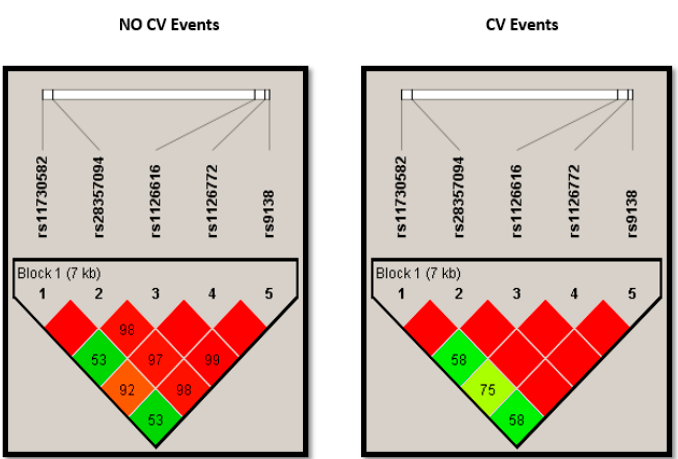
Figure 1. Plots showing linkage disequilibrium (LD) of alleles at different SNPs of SPP1 in chronic kidney disease patients stratified according to the presence of cardiovascular events. SNPs: single nucleotide polymorphisms; SPP1 : Osteopontin gene; CV: cardiovascular.